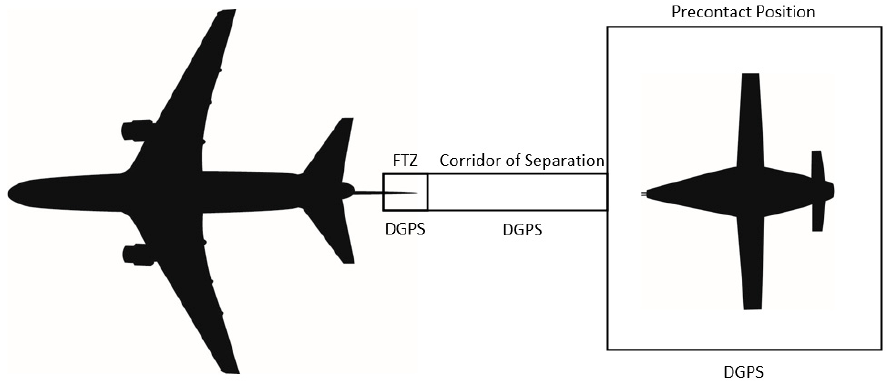
Figure 13. Sensors required for safe separation after refueling.